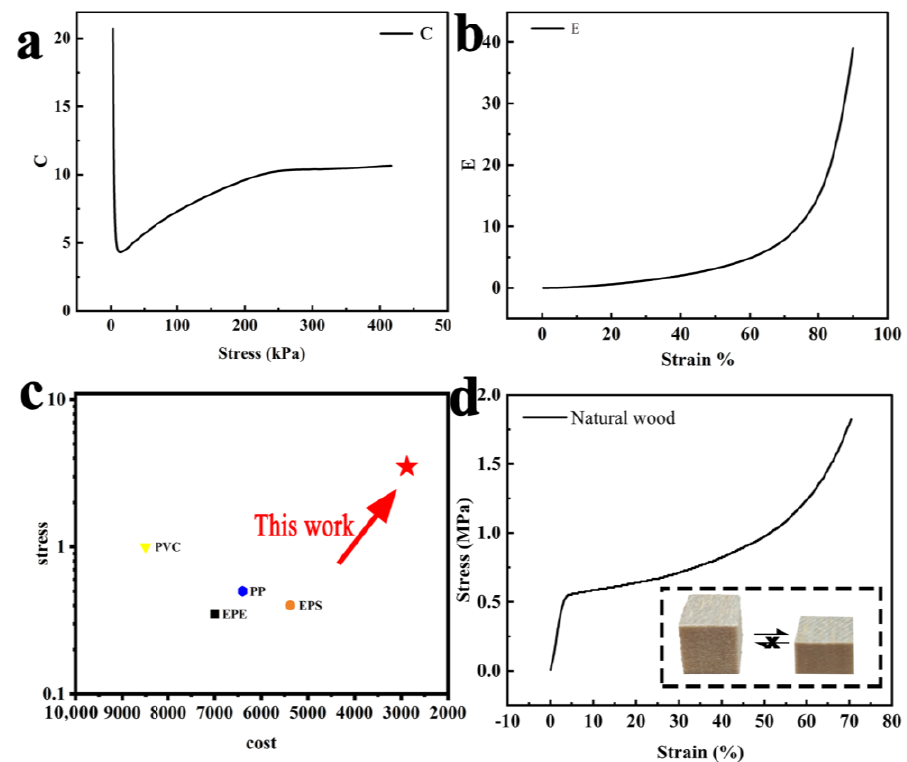
Figure 4. ( a ) Cushioning factor of the elastic wood. ( b ) Energy absorption under different strains. ( c ) Comparison of the mechanical properties and costs of different materials. ( d ) Diagram of natural wood compression and stress–strain curves of the natural wood.